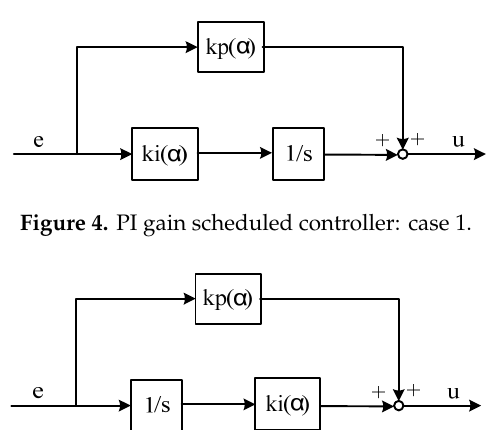
Figure 3. Step responses with a single proportional–integral (PI) controller.